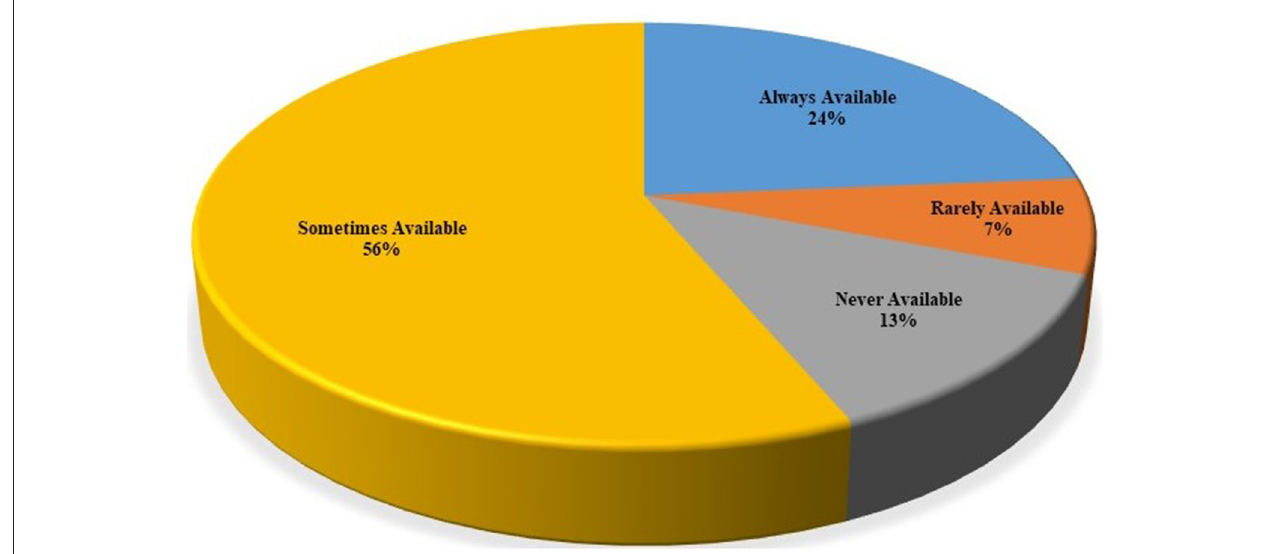
FIGURE 7 | Distribution showing the availability of improved seeds in the study